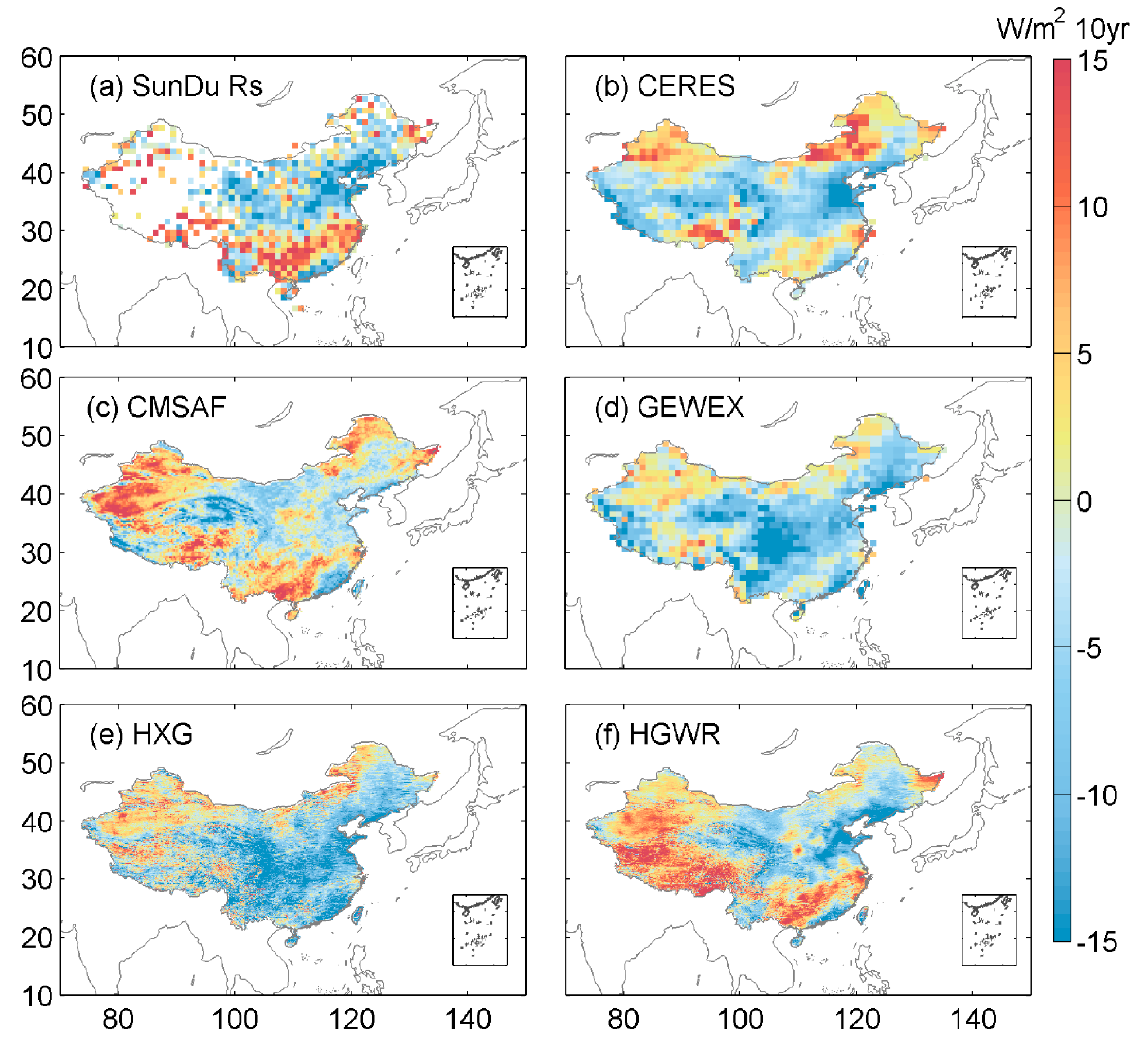
Figure 4. Spatial distributions of trends for R s from 2000 to 2007. The first line ( a , b ) shows the SunDu-derived R s and CERES EBAF R s (CERES); the R s -derived CMSAF CLARA-A2 (CMSAF) and GEWEX-SRB (GEWEX) are shown in the second line ( c , d ). Subplots ( e , f ) represent ISCCP-HXG-derived R s (HXG) and ISCCP-HXG merged with SunDu-derived R s